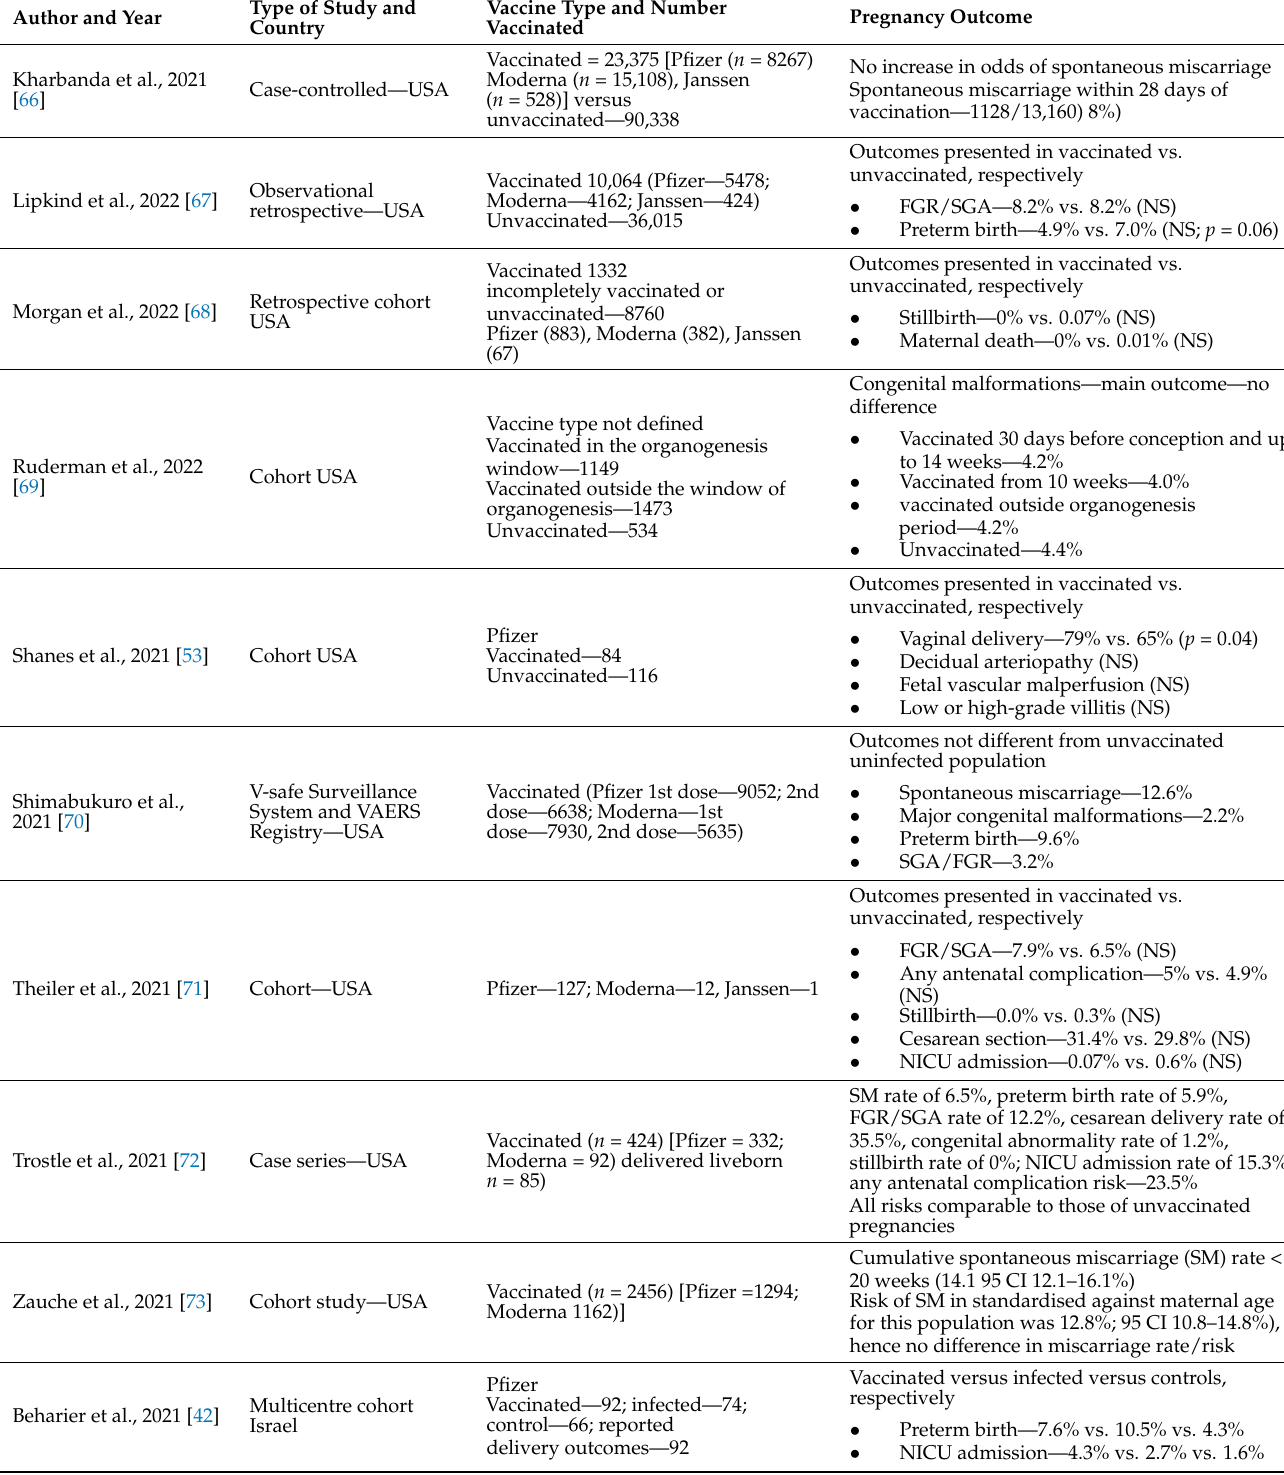
Table 3. Summary from studies that report on pregnancy outcomes after COVID-19